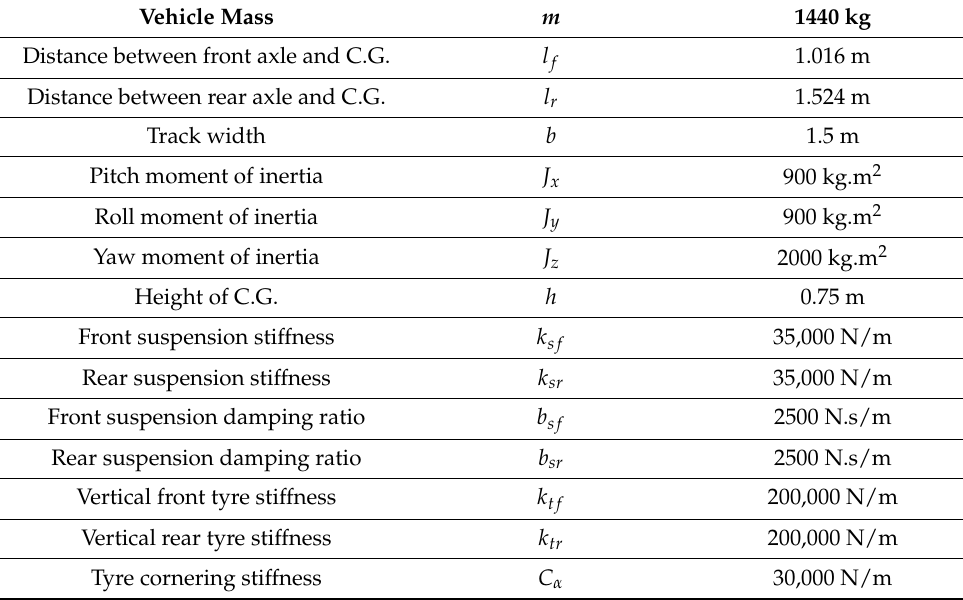
Table 1. Vehicle parameters of 8 DOF model and 14 DOF model (same as [7]). Vehicle Mass m 1440 kg Distance between front axle and C.G. l f 1.016 m Distance between rear axle and C.G. l r 1.524